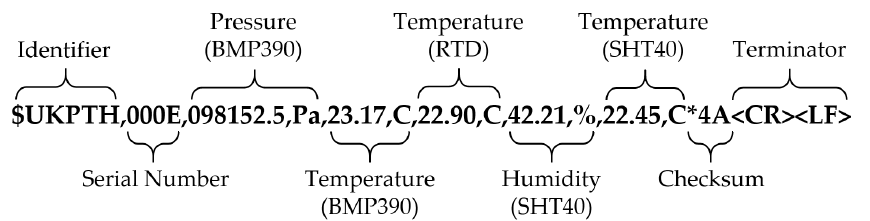
Figure 3. Example formatted string transmitted from the PTH probe to the host at 1 Hz over 3.3 VDC TTL UART. The checksum was the bit-wise exclusive OR of all 8-bit ASCII characters between the ‘$’ and ‘*’ characters and displayed as a 2-digit hexadecimal number. The terminator comprised the non-printable carriage return <CR> and line feed <LF> characters.